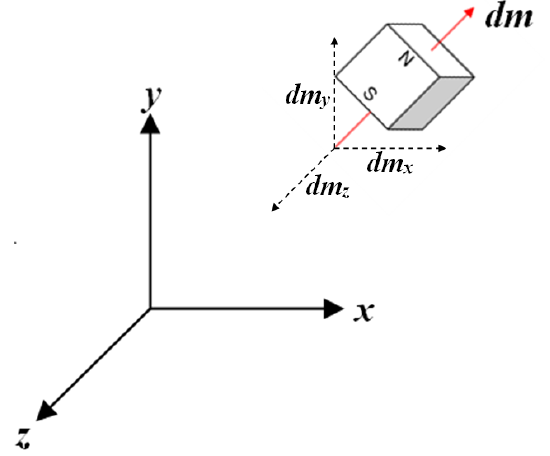
Figure 4. Magnetic dipole element and the magnetic